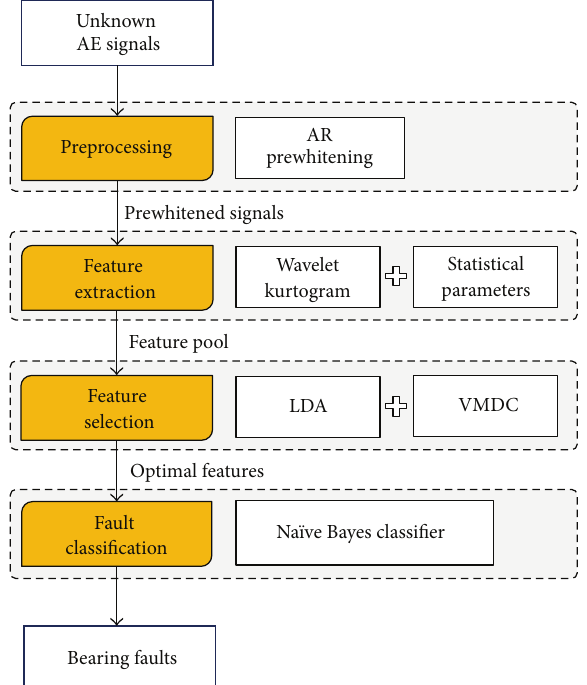
Figure 1: Flowchart of the proposed bearing fault diagnosis